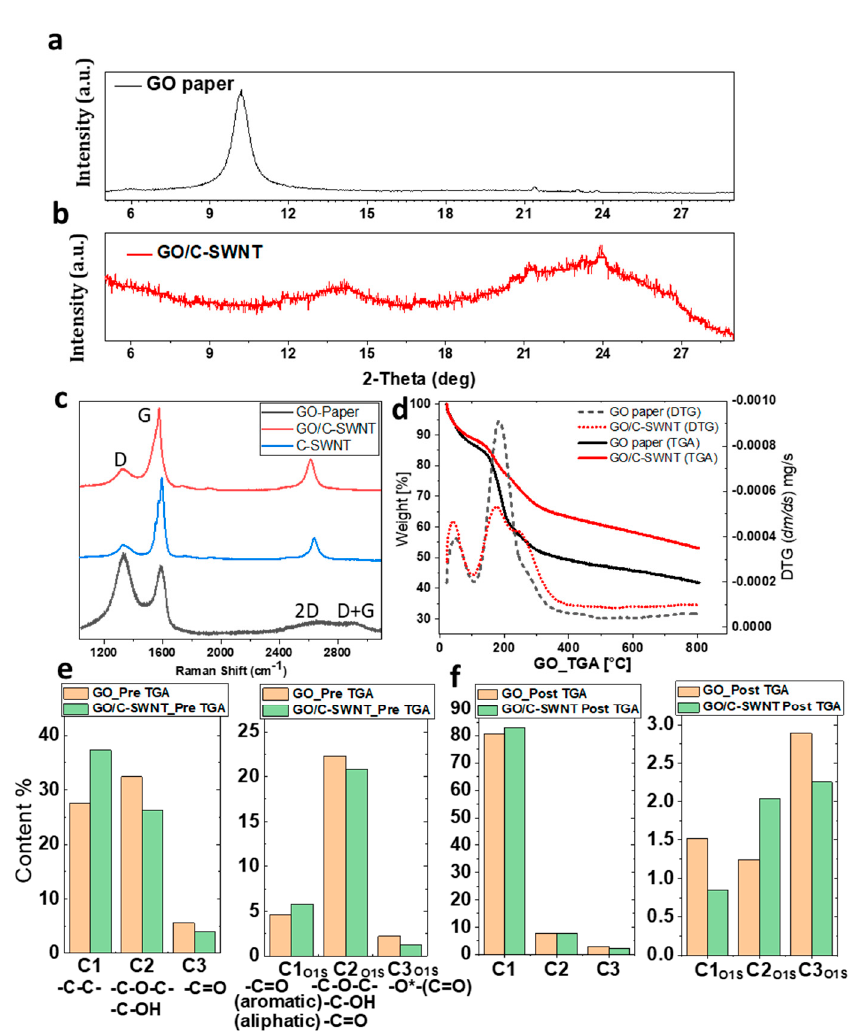
Figure 2. ( a , b ) XRD spectra of GO and GO/C-SWNT paper for 2 θ range between 5–30°. ( c ) Raman spectra of pure C-SWNT, GO-paper and GO/C-SWNT in the range from 1000 cm − 1 to 3200 cm − 1 showing characteristics D, G, and 2D peaks. Inset shows the zoomed region of 2D and D+G peaks for the native GO-paper. ( d ) TGA (thermogravimetric analysis) recorded from 20 °C to 800 °C with the degradation of GO and GO/C-SWNT in Ar- atmosphere, inset DTG curves shows the rate of mass loss at different temperatures. ( e , f ) Histogram from XPS data measured for C1S and O1S of GO and GO/C-SWNT of pre and post TGA treatment showing the presence of aliphatic and functional carbon groups.